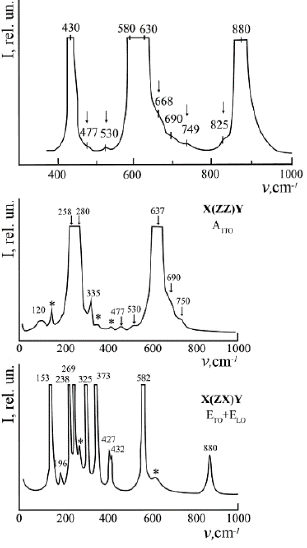
Figure 1. Raman spectra of a CLN single crystal at T = 77 K. The upper figure is the spectrum of a CLN single crystal heated at 1200 K for 6 h. Extra bands are marked with arrows.